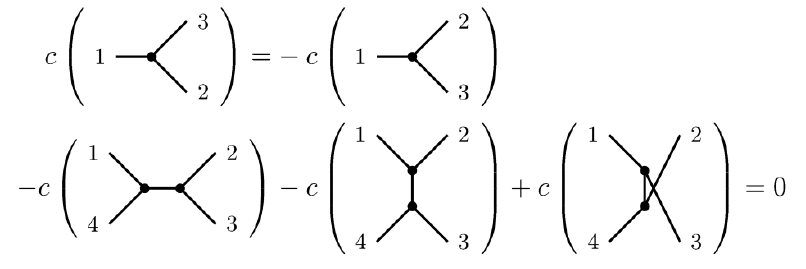
Figure 1 . Colour anti-symmetry relation and Jacobi